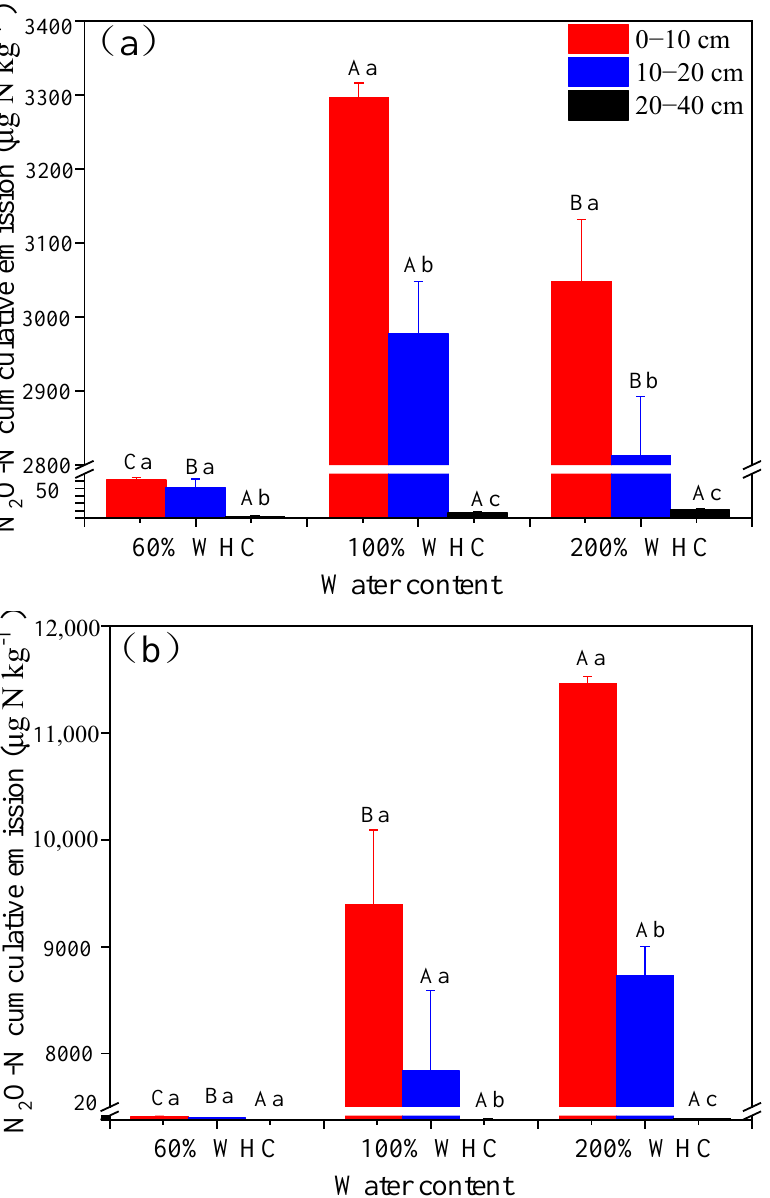
Figure 2. Effects of soil layers (0 − 10, 10 − 20, and 20 − 40 cm) and soil moisture (60%, 100%, and 200% WHC) on cumulative N 2 O emissions in hydromorphic ( a ) and gleyed ( b ) paddy soils. Values are the means of three replicates, and the error bars represent standard errors. Different capital letters above the columns denote significant difference between soil moisture for a given depth at p < 0.05. Different lowercase letters above the columns denote significant difference between soil depth for a given moisture at p < 0.05.